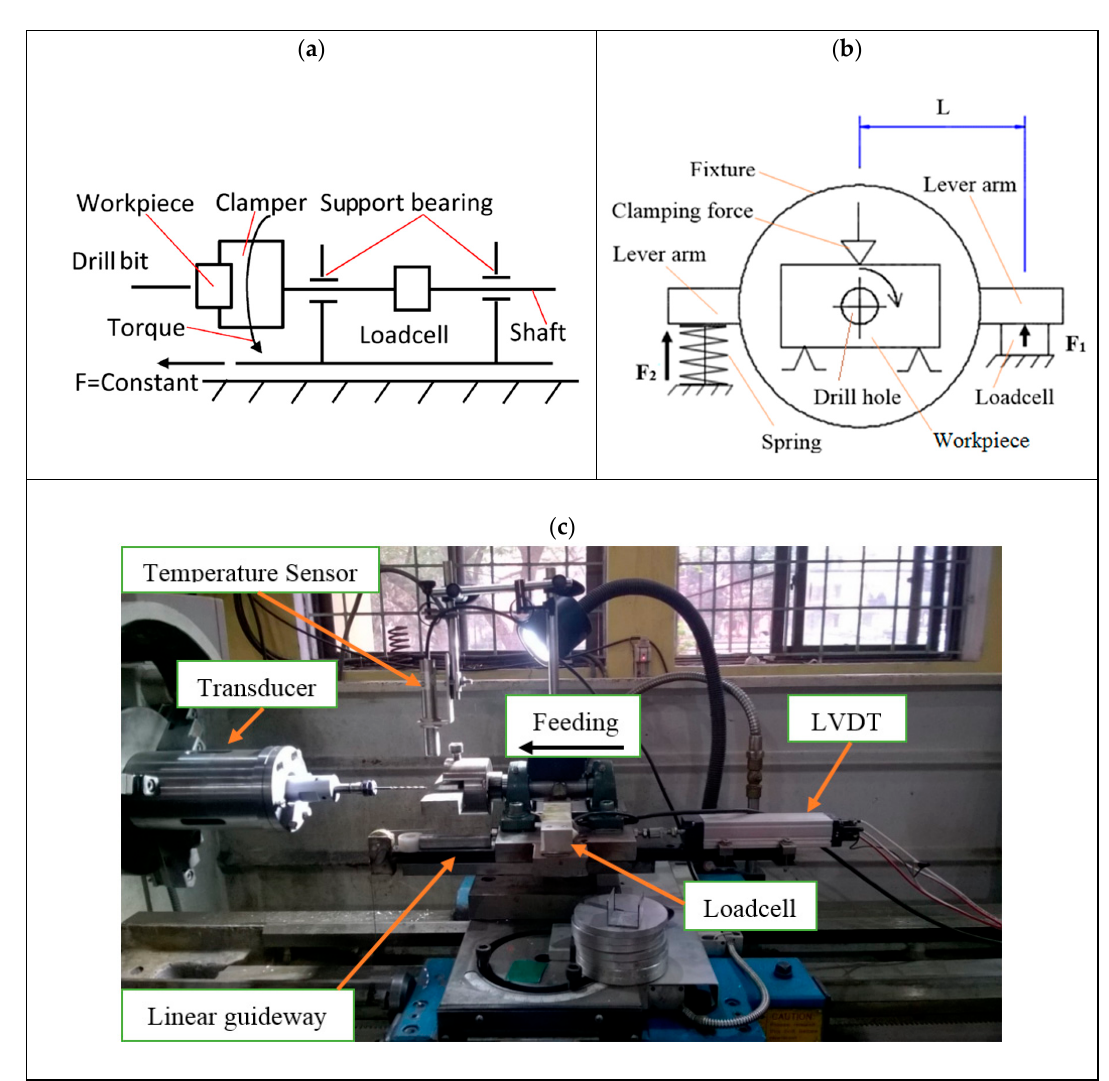
Figure 3. Technical schemata ( a ) in front view and ( b ) cross-sectional view, and ( c ) a photograph of the complete experimental fixture setup. (LVDT: linear variable displacement transducer.)